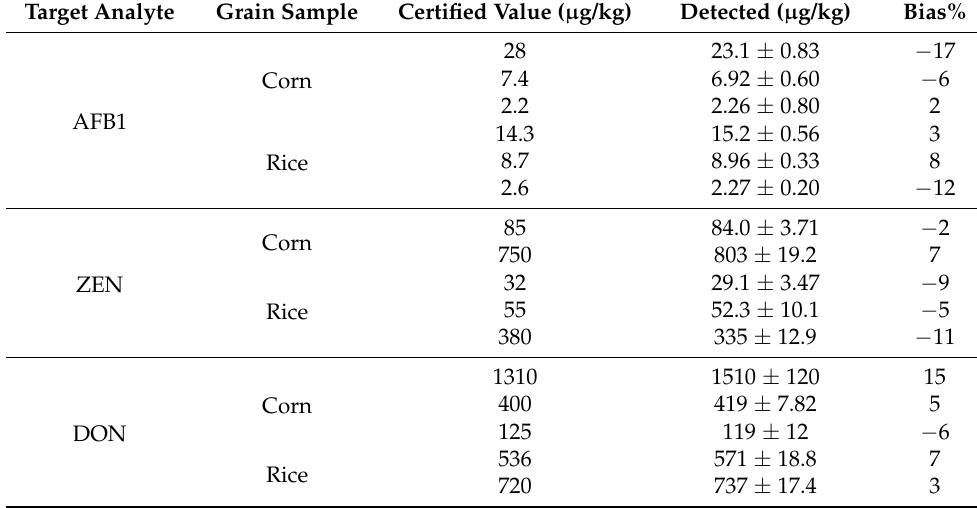
Table 3. Comparison of the detected AFB1, ZEN and DON concentrations obtained by this method and its certified concentrations in